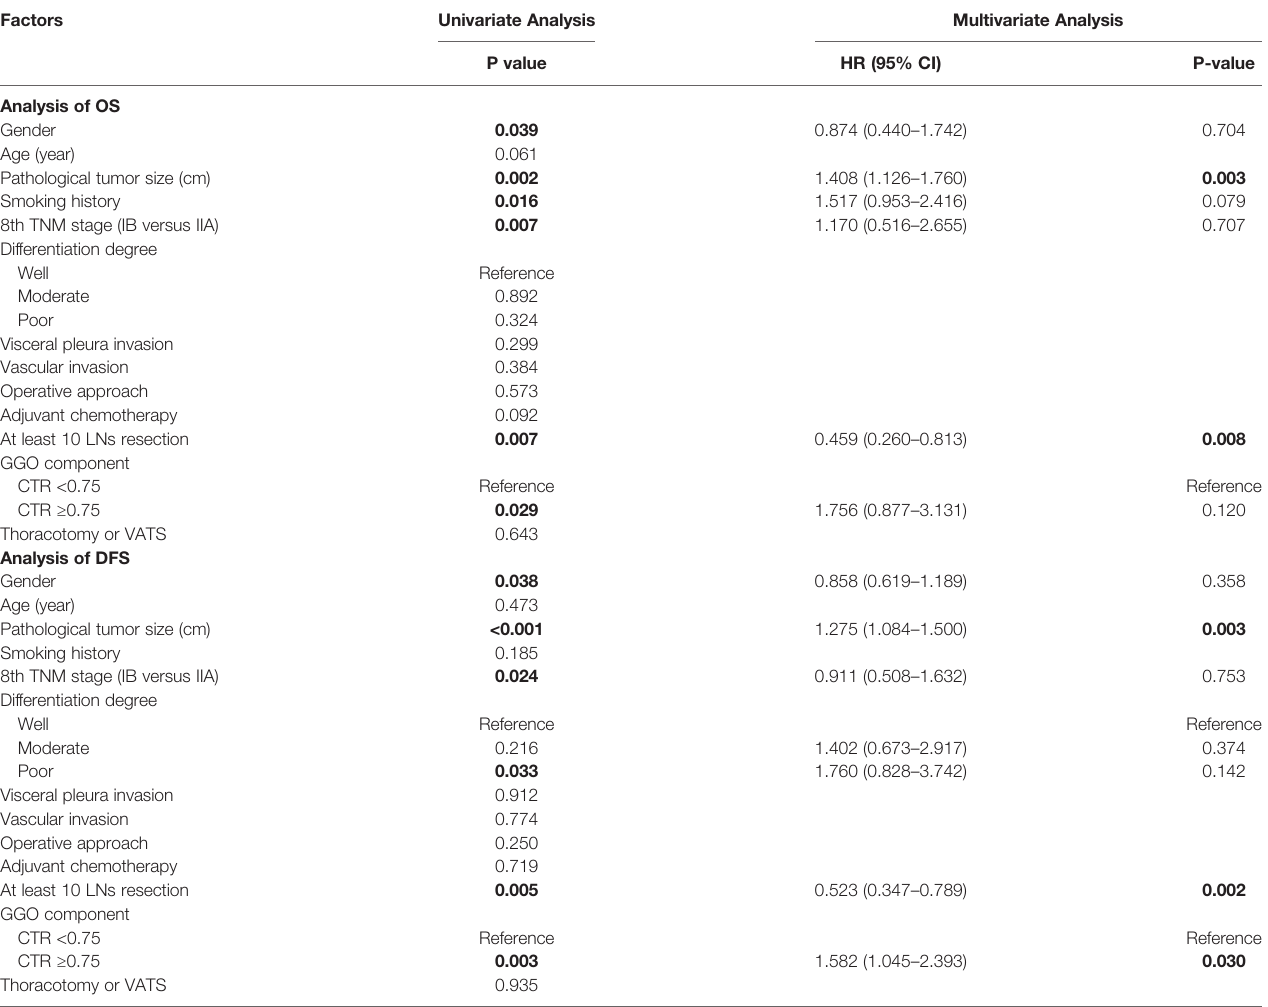
TABLE 2 | Univariate and multivariate analyses for all